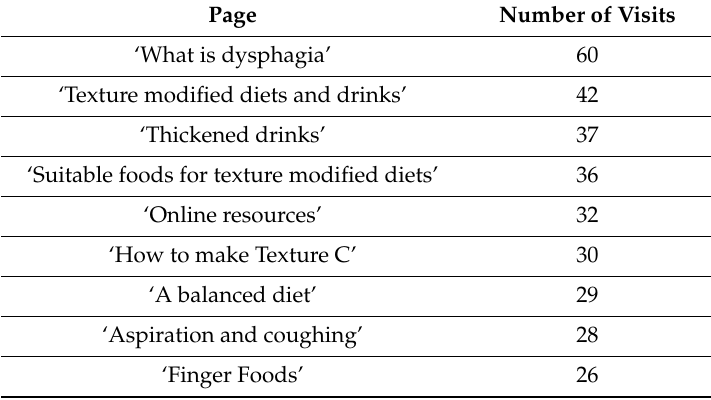
Table 1. Most visited paged in the digital dysphagia